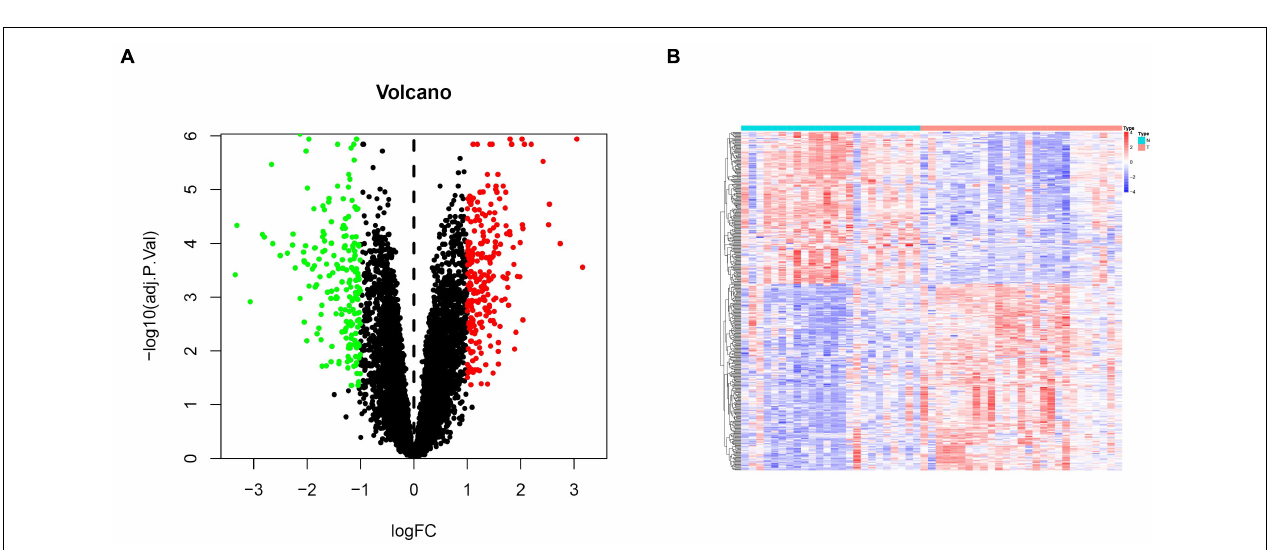
FIGURE 1 | Principal component analysis (PCA) showing patterns of gene expression across datasets. Points of the scatter plots represent samples based on the top two principal components (PC1 and PC2) of gene expression profiles without (A) and with (B) the removal of batch effect. Colors denote corresponding samples across three different datasets.